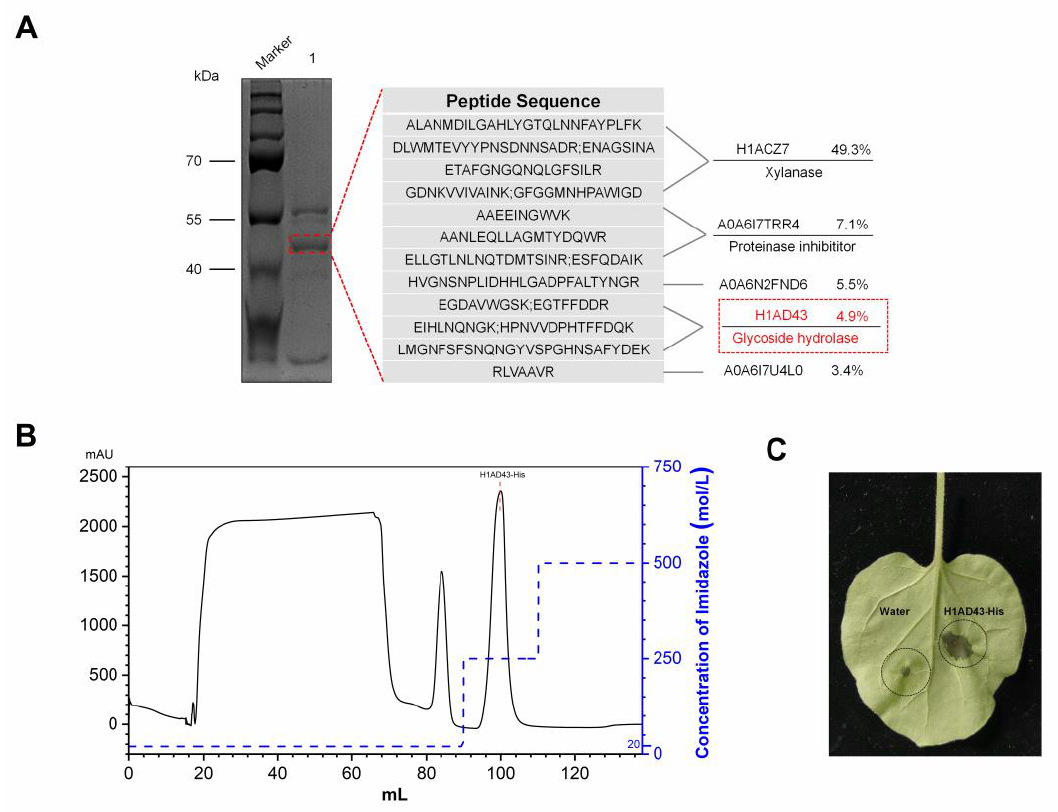
Figure 2. Identification and activity verification of the BL06-1A protein. ( A ) Mass spectrometry analysis of the BL06-1A protein; ( B ) Elution curve of H1AD43 in a His-Trap HP column; ( C ) Induction of cell death in N. benthamiana leaves by H1AD43.